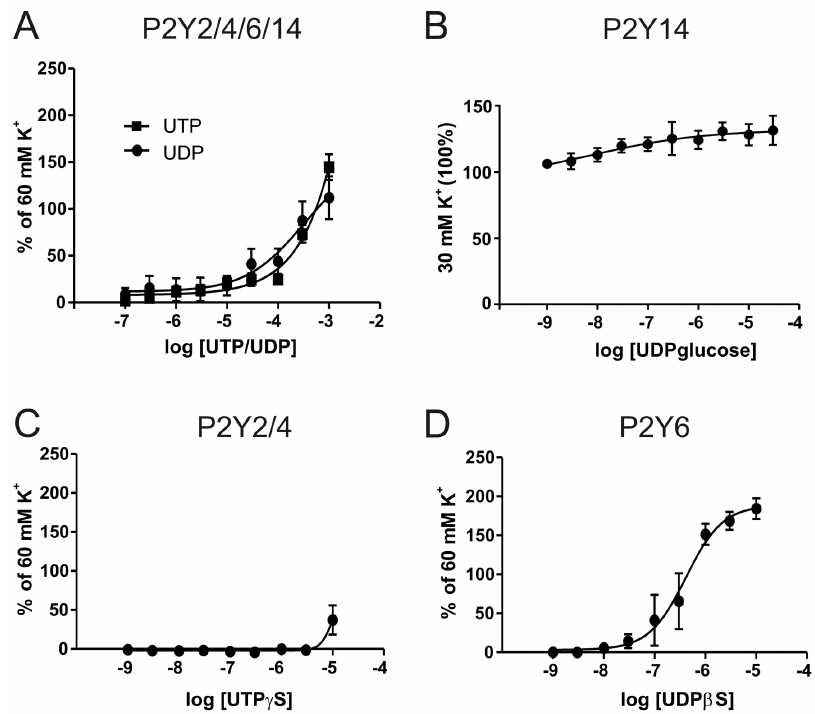
Figure 4. Contractile responses to pyrimidine nucleotides. Contractile responses to UTP (P2Y2/4) and UDP (P2Y6/14) (A), to UDP-glucose a P2Y14 agonist on vessels pre-contracted with 30 mM potassium (B), the non-degradable UTP analogue UTP c S, a specific P2Y2/4 agonist (C) and the non-degradable UDP analogue UDP b S, a specific P2Y6 agonist (D). (n=5)